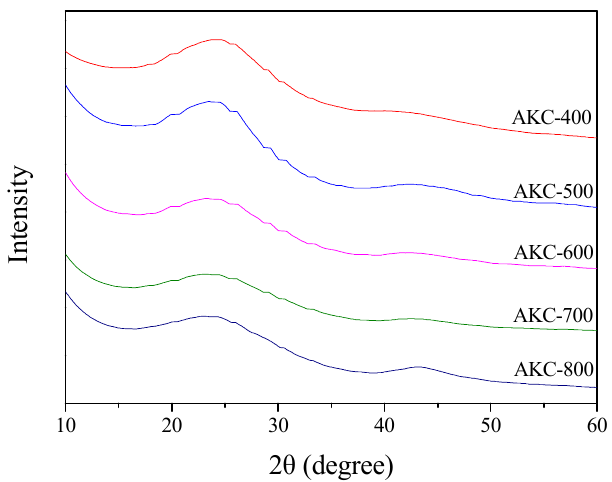
Figure 2. X-ray diffraction patterns of kenaf-derived activated carbons as a function of various phosphoric acid activation temperature.